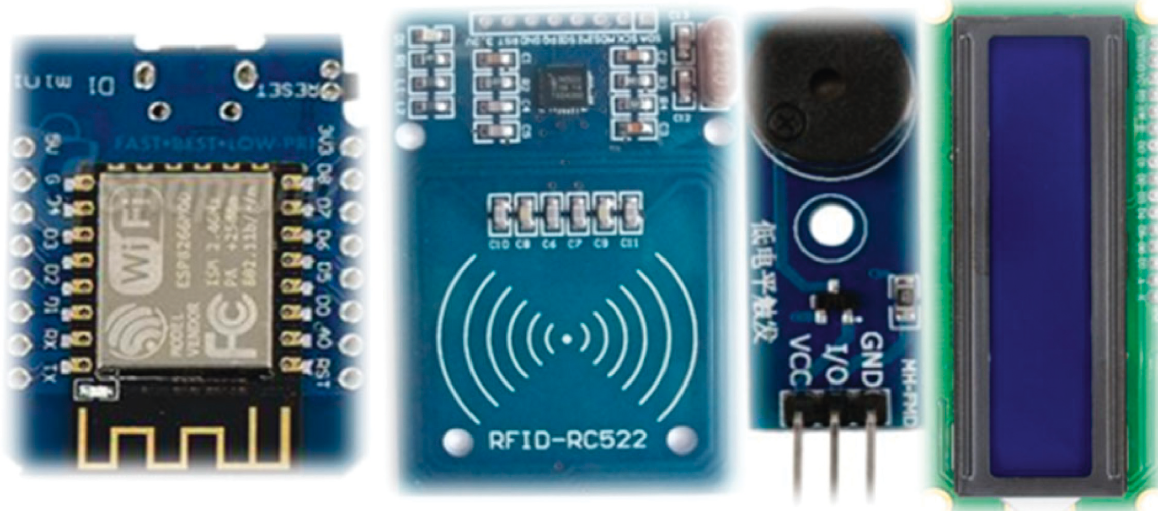
Figure 4: Components of the card screener (from left): a WeMos D1 mini, an RFID reader, a buzzer, and an I2C LCD.